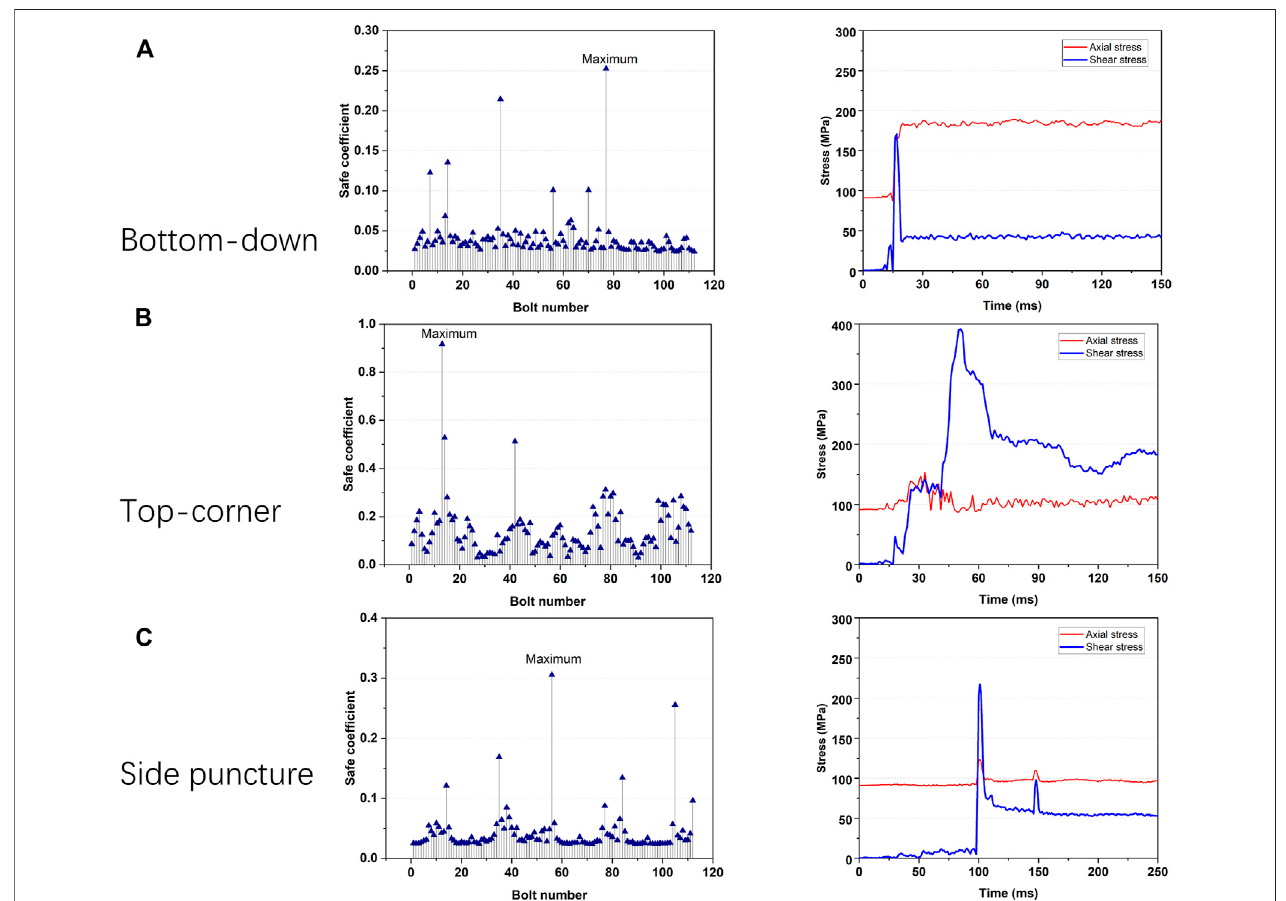
FIGURE 12 | Bolt safe coef fi cient and stress of (A) bottom-down drop test (B) top-corner drop test (C) side puncture test.